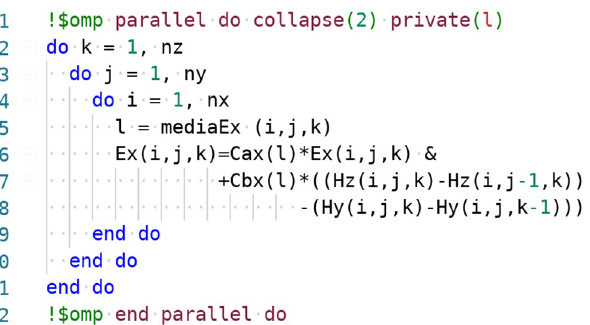
Fig 3. Fortran code to advance the x -component of the E -field. Piece of code extracted from the advancing routines of the SEMBA-UGRFDTD solver developed by the authors (http://www.sembahome.org).